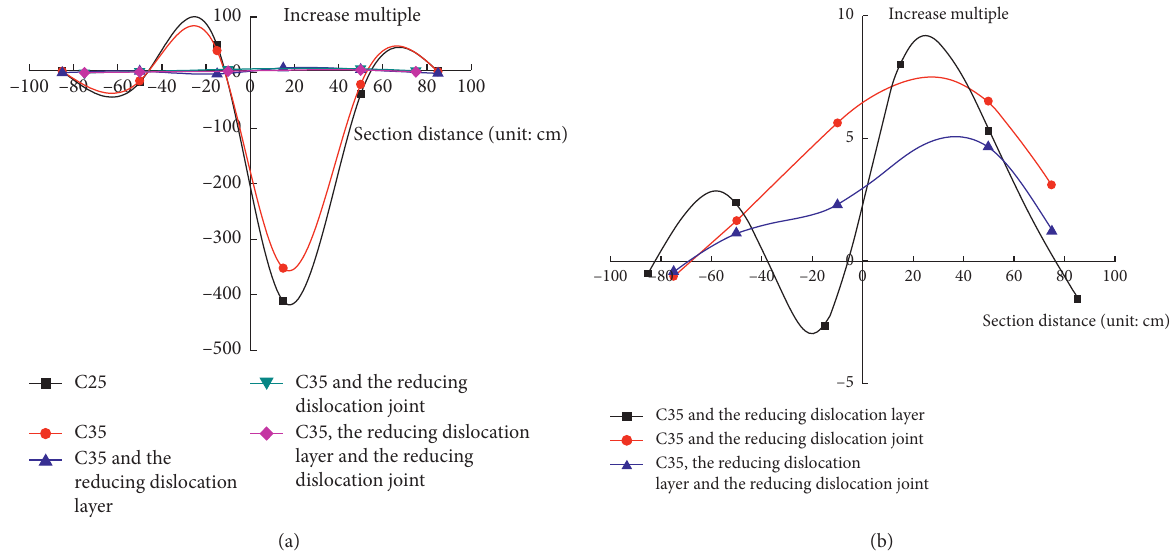
Figure 8: Increase multiple of longitudinal strain. (a) The operating conditions 1 to 5. (b) The operating conditions 3 to 5.